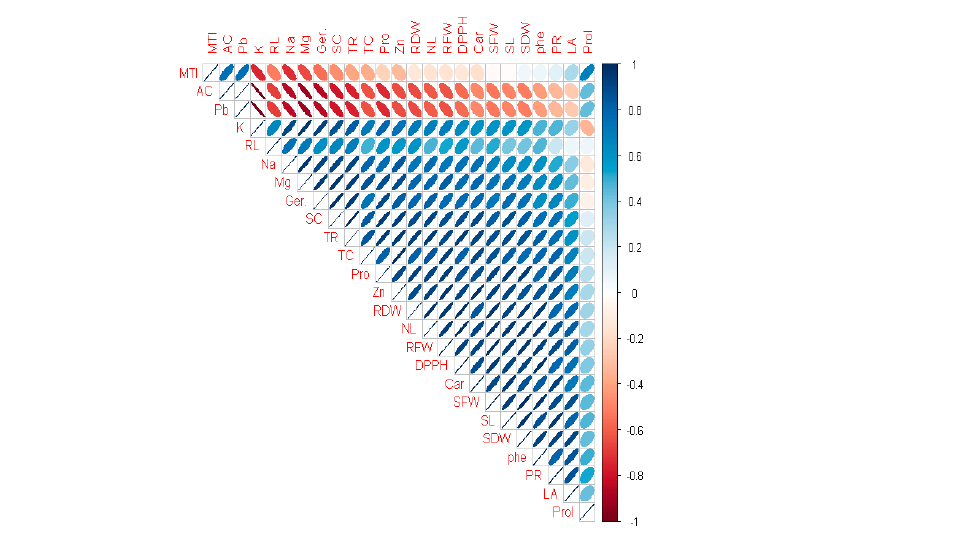
Figure 3. Correlation between growth and physiological parameters of Phaseolus vulgaris L. grown under Pb soil with the application of Tria as seed primer. Different abbreviations used in the figure are as follows: SL (shoot length), RL (root length), NL (number of leaves), LA (leaf area), Ger. (Germination percentage), SFW (shoot fresh weight), RFW (root fresh weight), SDW (shoot dry weight), RDW (root dry weight), TC (Total chlorophyll contents), Car (carotenoid contents), Mg